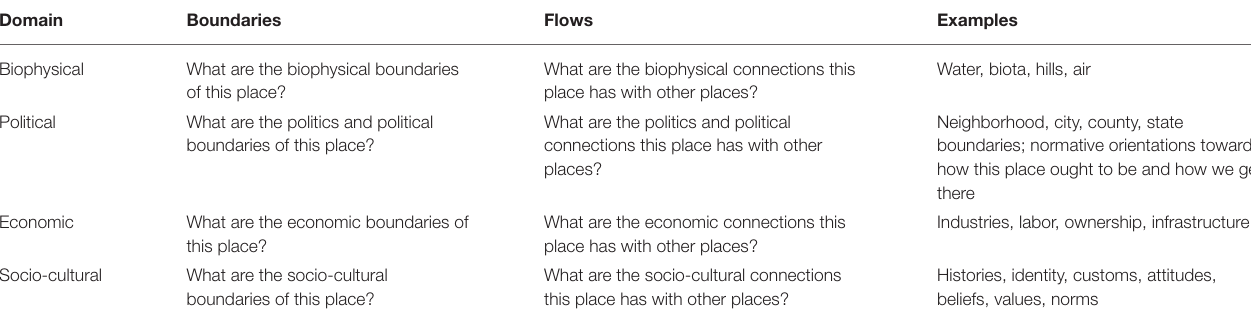
TABLE 1 | Operationalizing place as practice: domains, boundaries, and flows.